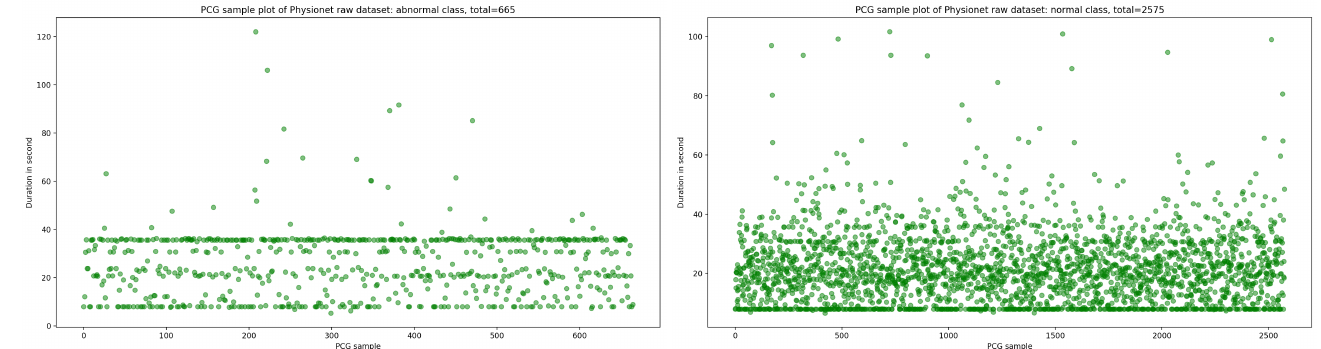
Figure 1. An overview of normal and abnormal sample distribution in function of duration in second.